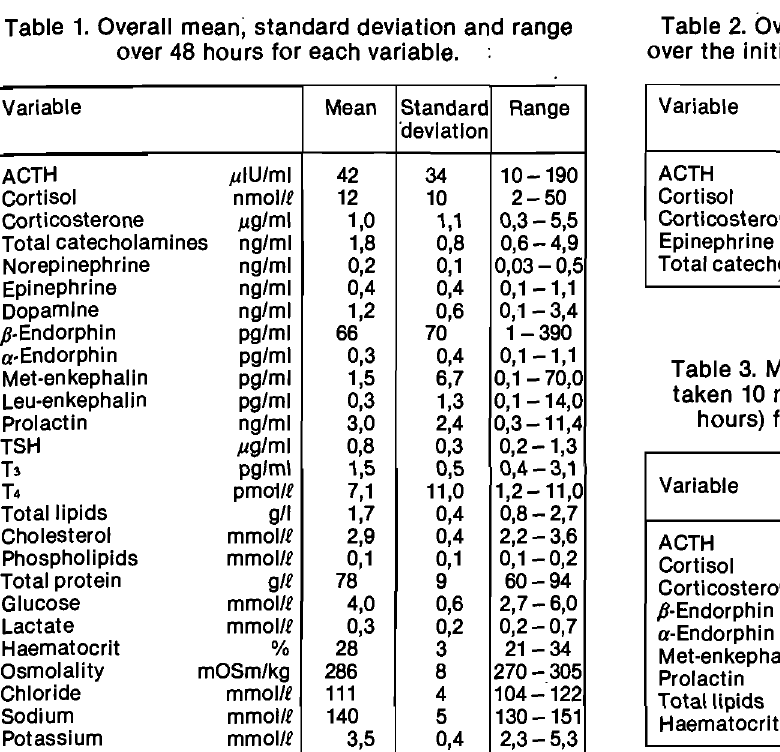
Table 1. Overall mean; standard deviation and range over 48 hours for each variable. Variable